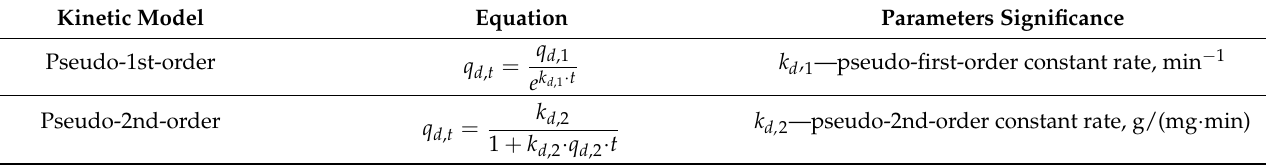
Table 5. Desorption kinetic models equations.